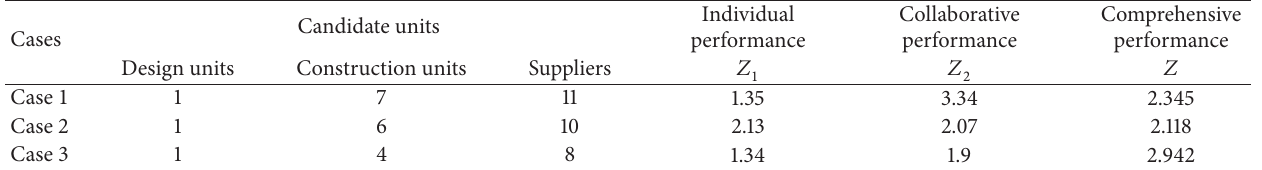
Table 9: Comprehensive performance of the three